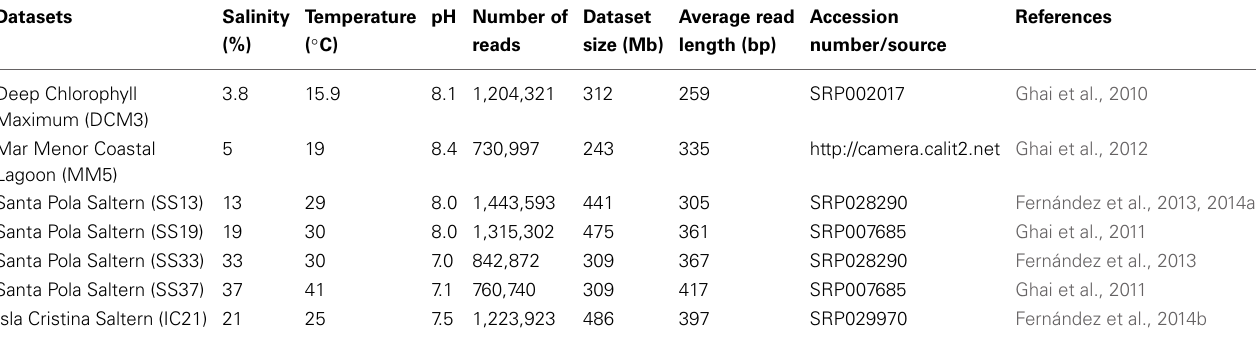
Table 1 | Features of the different datasets from saline habitats used in this